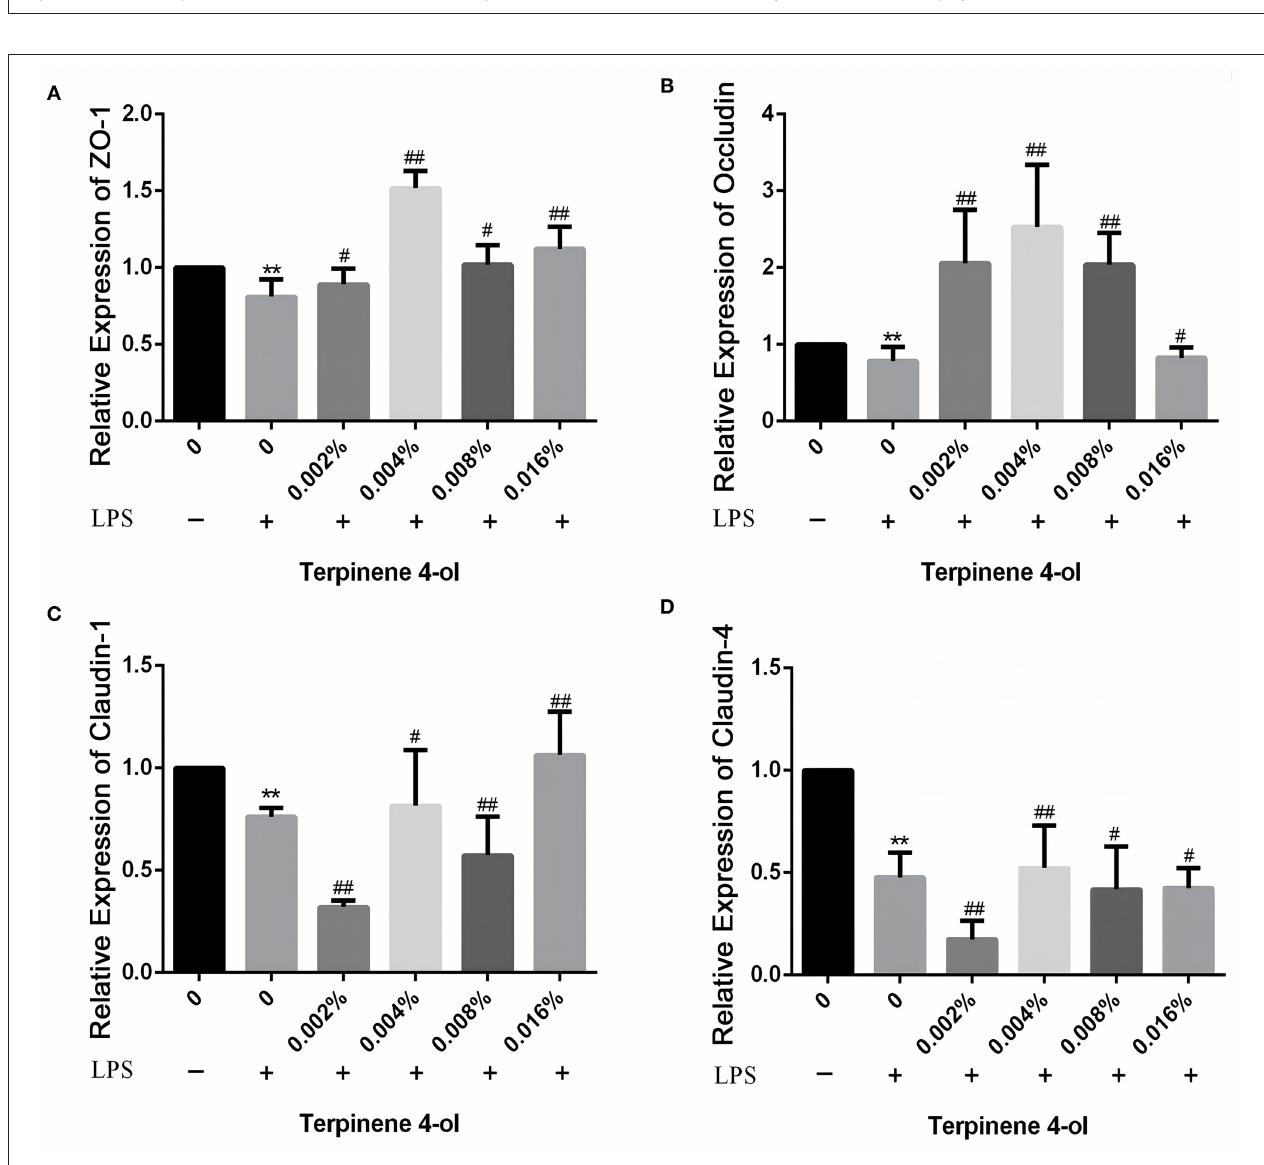
FIGURE 3 | (A) TEER values. Cells were treated with LPS on day 17 after differentiation, and TEER values were detected at different times (B–D) . Cell permeability was measured by determining FITC-dextran permeability after 24h of LPS exposure in TER-treated cells (E) . The IL-6 (F) and TNF- α (G) levels in the culture supernatants of cells pretreated with TER for 24h and then exposed to LPS for 3h were measured by ELISA. ** and ## display similar means with above mentioned.